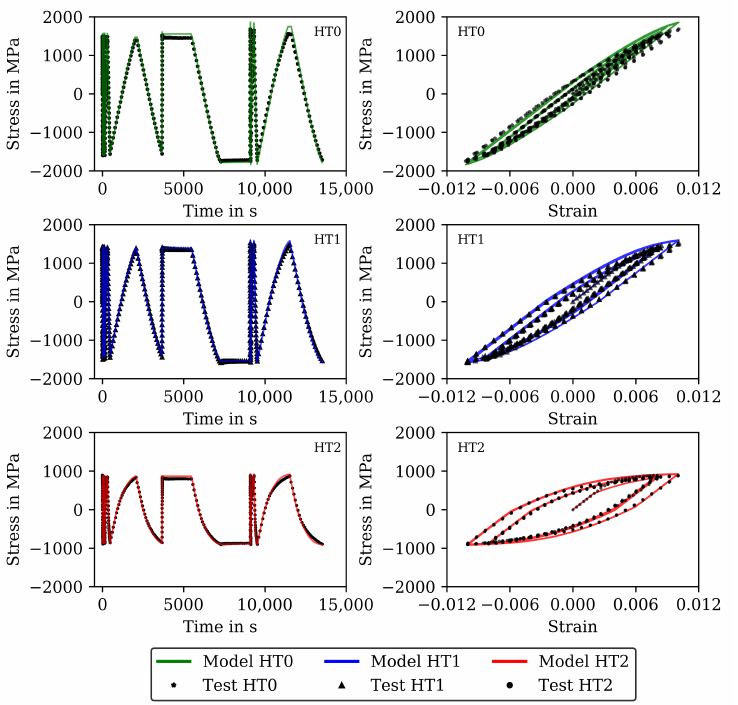
Figure 2. Measured stress and stress calculated with the model of step 1 for the initial (11) cycles of the CLCF tests at 20 ◦ C for the HT0, HT1, and HT2 material. Stress-time diagrams ( left ) and stress–strain hysteresis loops ( right